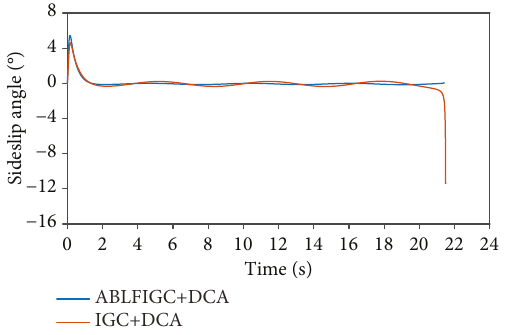
Figure 8: Curves of angular velocities of vertical line of sight of the interceptor missile in Scenario 2: ABLFIGC+DCA refers to a combination of the proposed asymmetric barrier Lyapunov function-based IGC algorithm and the dynamic control allocation algorithm; IGC+DCA refers to a combination of the IGC algorithm subject to the traditional dynamic surface sliding-mode control law and the dynamic control allocation algorithm.